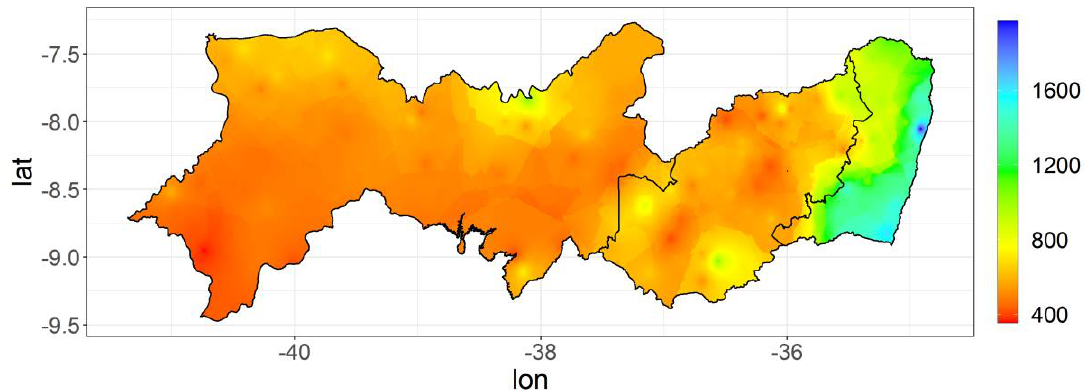
Figure 2. Mean annual precipitation, interpolated over the study area.